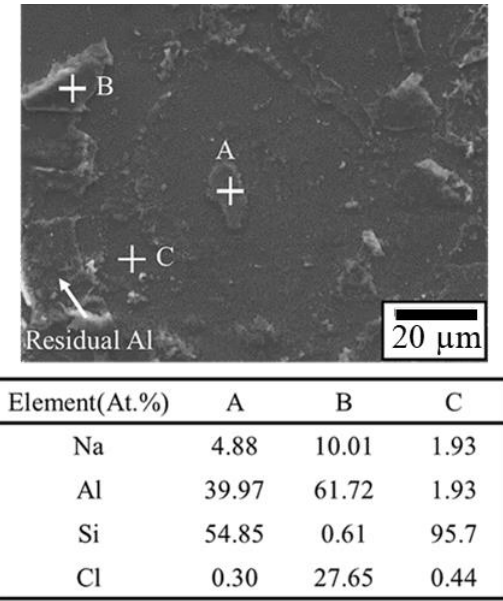
Figure 7. Fracture position of the first bond of the APAP wire after chlorination: ( a ) 10 min and ( b ) 30 min.